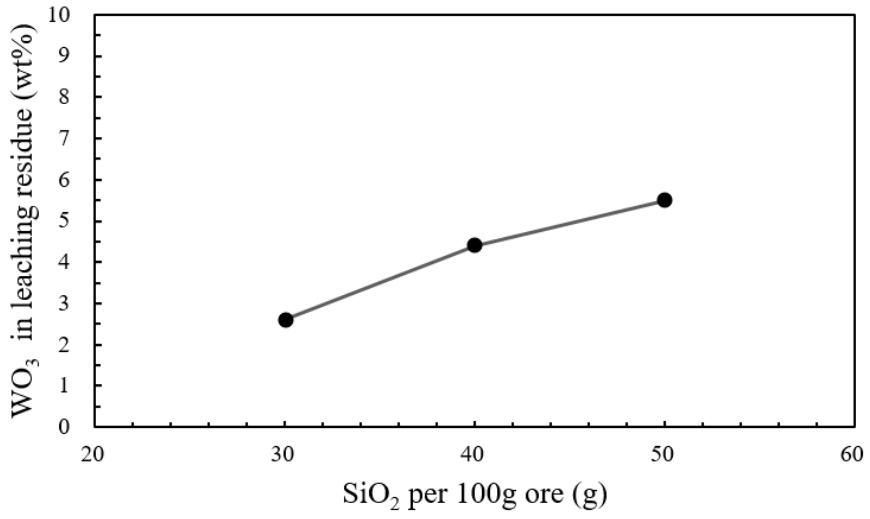
◦ C in air with 54.3% Na 2